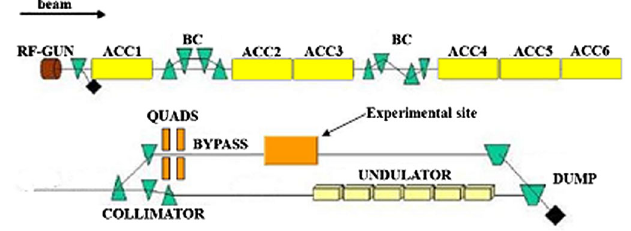
FIG. 6. FLASH layout during our experiment (not to scale).